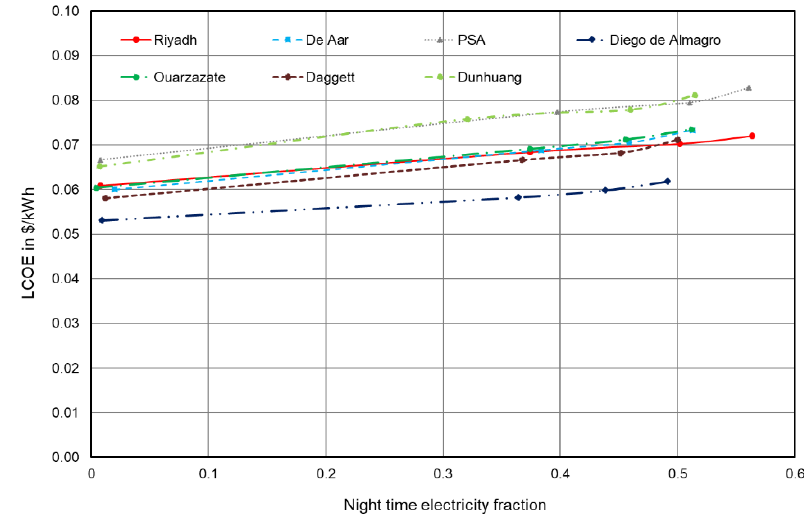
Figure 9. Comparison of locations: